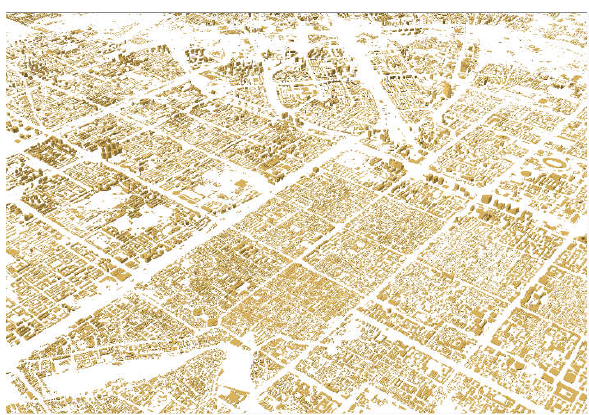
Figure 8 Model of The Lama Temple and its surrounding buildings (partial)